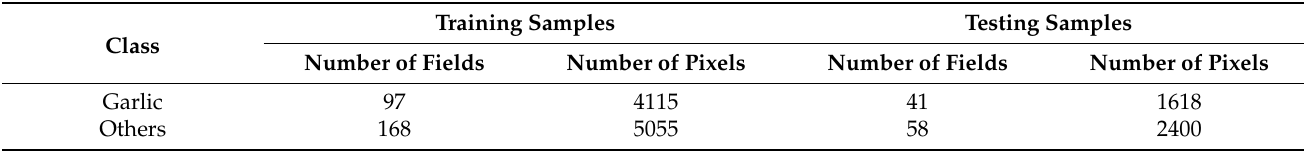
Table 2. Training and validation sample pixels for each date of